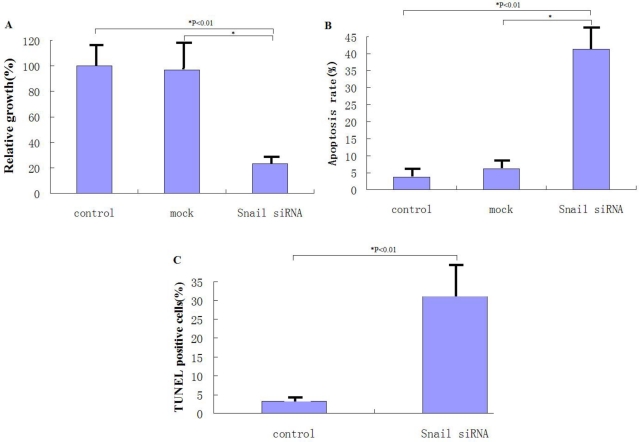
Knockdown of Snail suppresses the growth of pancreatic cancer cells through induction of apoptosis. (A) Cell growth was measured by MTT assay 48 hours after rAAV2-siRNA-Snail (or mock) infection (100 MOI), as described in Materials and Methods. Growth of untreated cells was defined as 100%. (B) Following the indicated treatments for 48 hours, levels of apoptosis were analyzed using annexin-V staining. (C) Following the indicated treatments for 48 hours, levels of apoptosis were examined using Hoechst 33324 and PI staining.